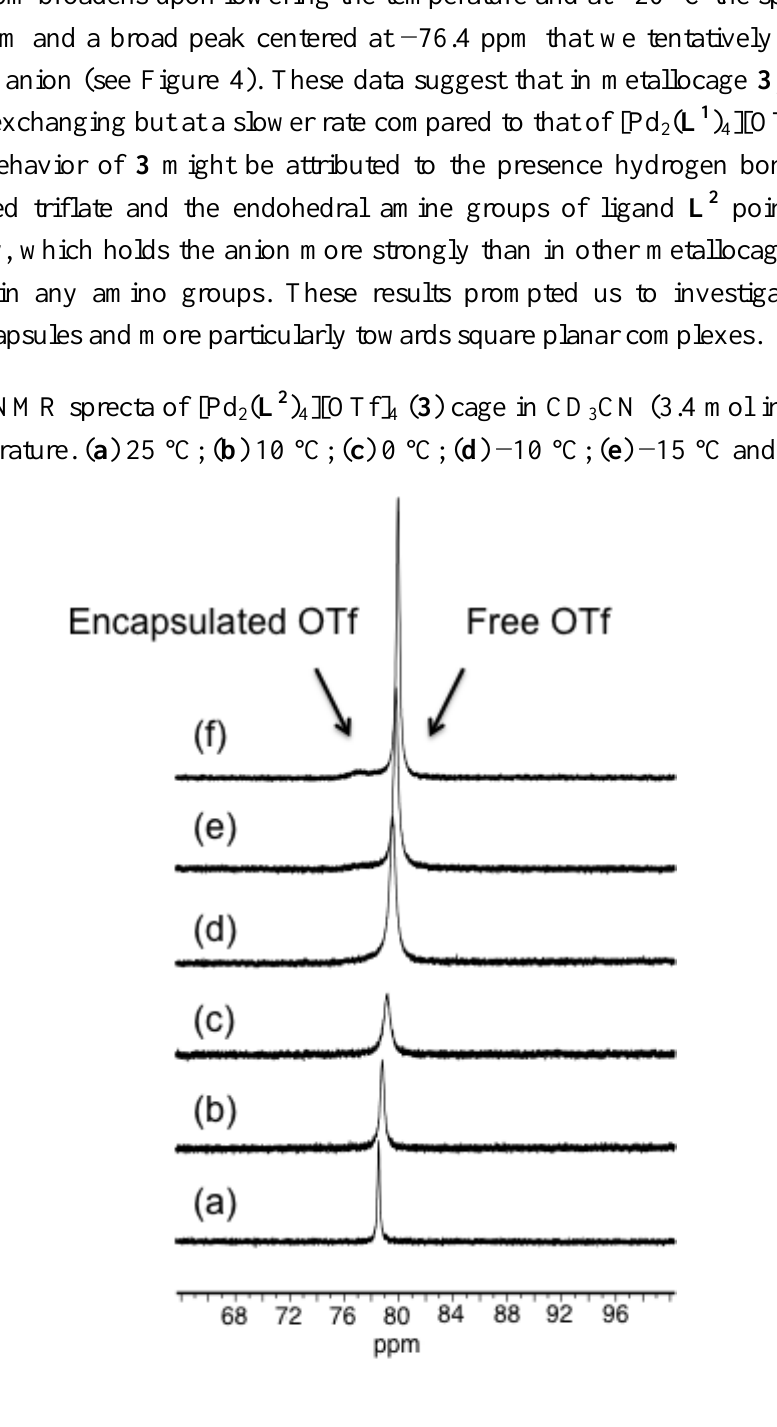
( L 2 ) ][OTf] ( 3 ) cage in CD CN (3.4 mol in 0.5 mL) at 2 4 4 3